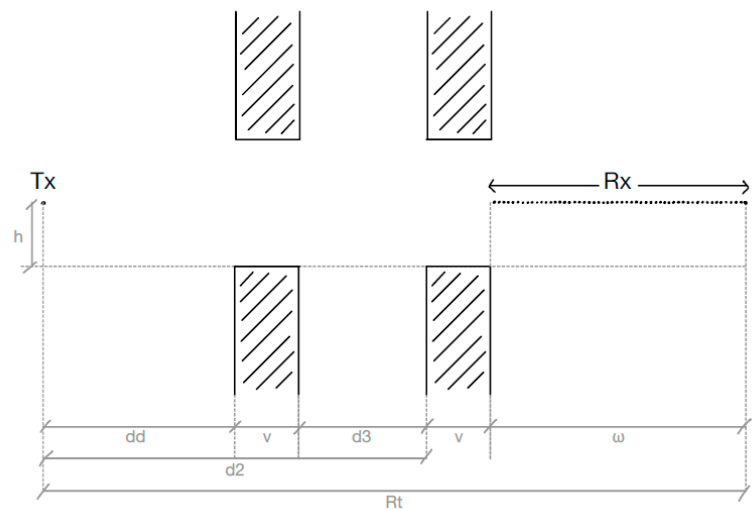
Figure 1. Scheme of the considered LOS